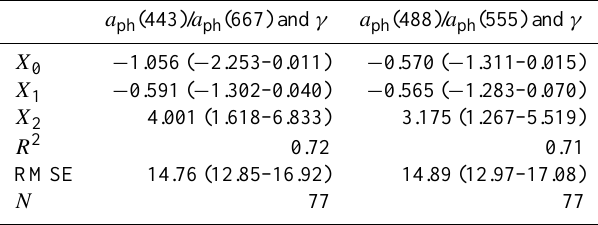
Table 4. Regression coefficients for SDM (Eq. 8) when a ph (443)/ a ph (667) and γ were used, and when a ph (488)/ a ph (555) and γ were used. Values in parentheses are 95% confidence inter- vals of each coefficient. RMSE are also provided. Values in paren- theses are 95% confidence intervals of each RMSE, which were computed assuming exponential distribution to the square errors.